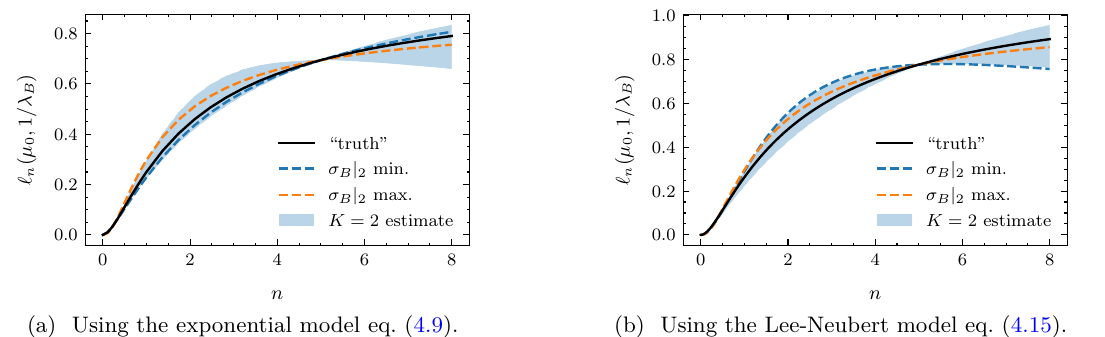
Figure 7 . Pseudo-fit to the normalized Laplace transform ‘ n ( µ 0 , 1 /λ B ) using the two pseudo- observables p as predicted by two models as a function of x = ω/λ 1 , 2 (“truth”), the curves that lead to extreme values of σ LCDA. For the latter, we take the benchmark interval for ξ = ω